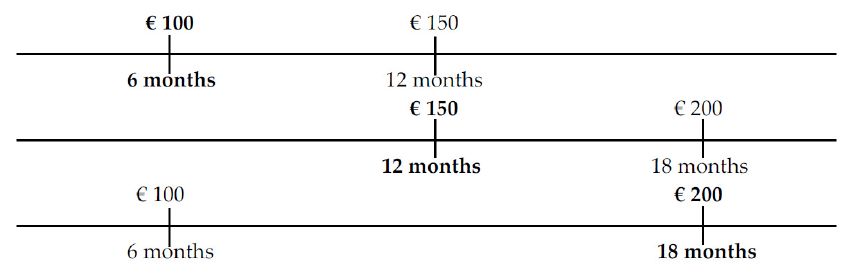
Figure 2. Subadditivity. Source: Own elaboration.